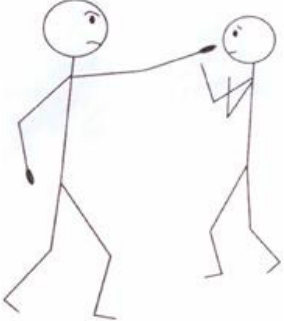
Figure A1. A cartoon: Individual physical aggression.